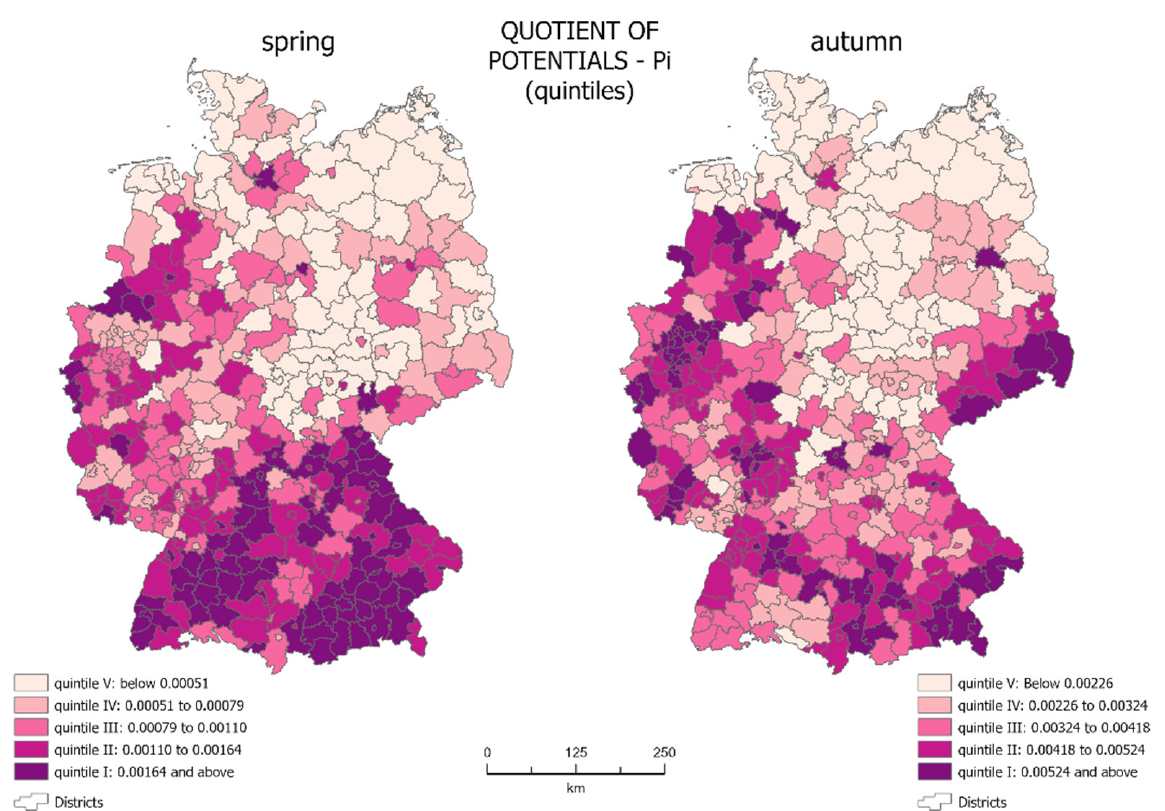
Figure 2. Choropleth maps of quotient of potentials (source: own work). The choropleth maps show that during the spring, the quotients of potentials were relatively small for most of the country, which means that the potential for infections was much lower than the potential of the population. In spring, the highest quotient of potentials (0.00164–0.01034) occurred mainly in the south of the country. The lowest quotient of potentials (below 0.00051) covers most of the eastern part of Germany—areas with lower population